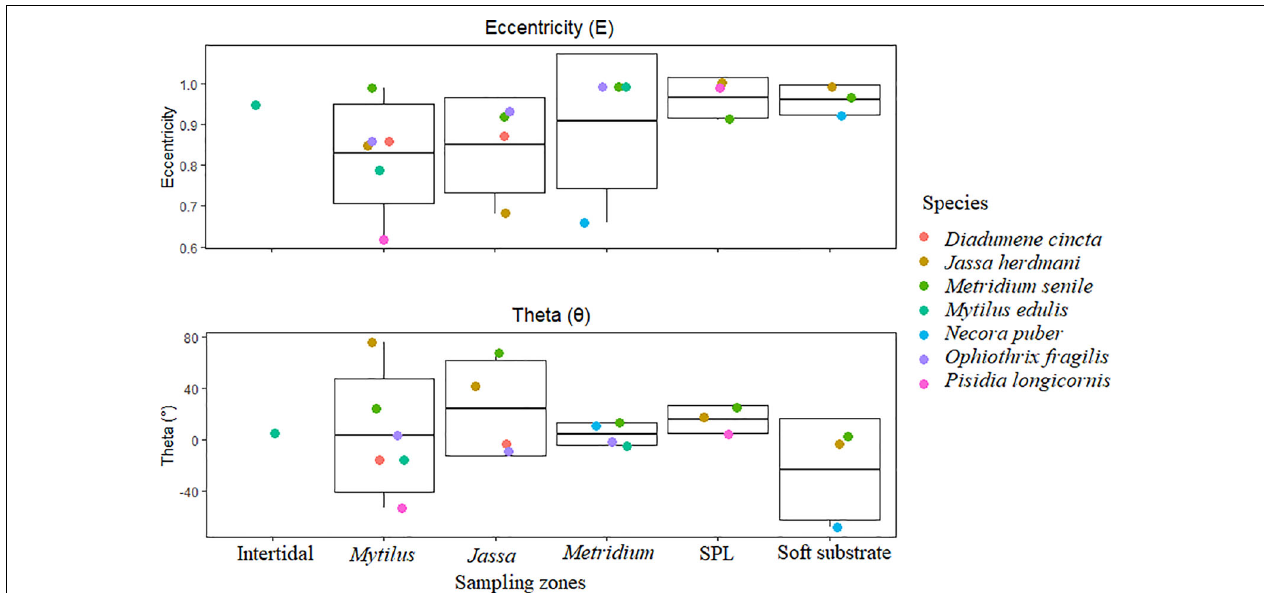
FIGURE 6 | Eccentricity (E – upper graph) and theta ( ◦ ) ( θ – lower graph) values of every species in the different zones (Intertidal, Mytilus , Jassa , Metridium , Scour Protection Layer – SPL and soft substrate). Each boxplot represents the median (middle horizontal line) and the lower and upper quartile (the lower and upper end of the boxplots, respectively) of eccentricity and theta in the different zones, while the whiskers represent the extreme highest and lowest observations. Intertidal was the only zone without enough replicates to generate a boxplot.